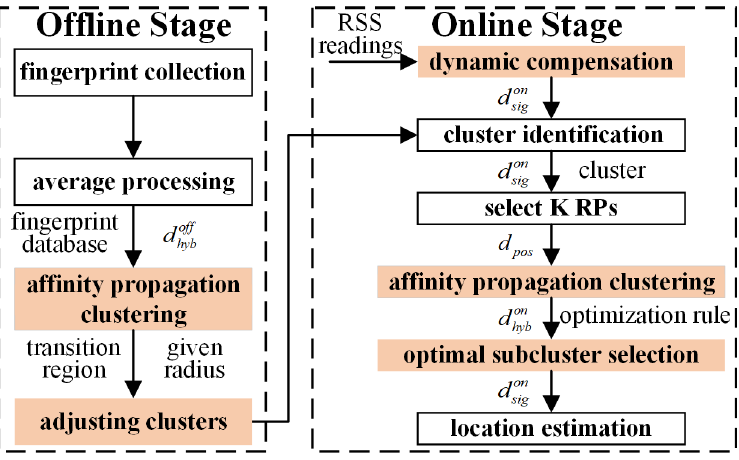
Figure 1. The overview of improved localization method. After collecting RSS measurements at some point in a period, many pairs of key values with MAC and RSS through average processing are named as the fingerprint, expressed as R =[ mac 1 , rss 1 ; mac 2 , rss 2 ; · · · ; mac n , rss n ] , where mac 1 denotes MAC of the first